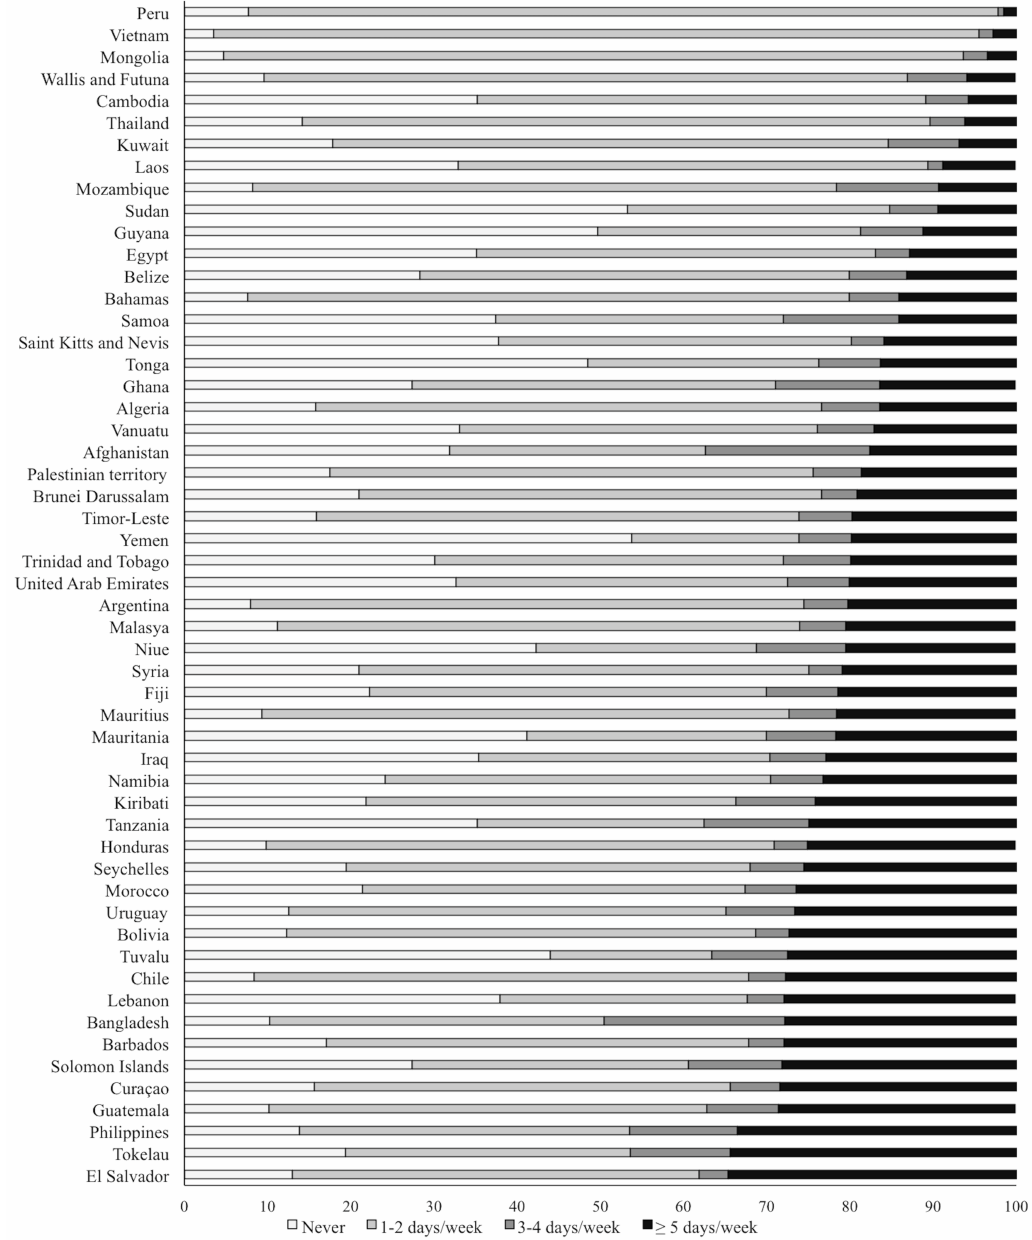
Figure 1. Participation in physical education classes by